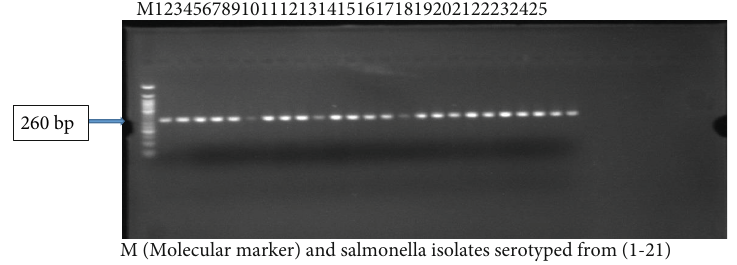
Figure 3: Ampli fi cation of invA gene from Salmonella serovars from intestinal contents and ready-to-eat chicken gizzards in the Ilorin